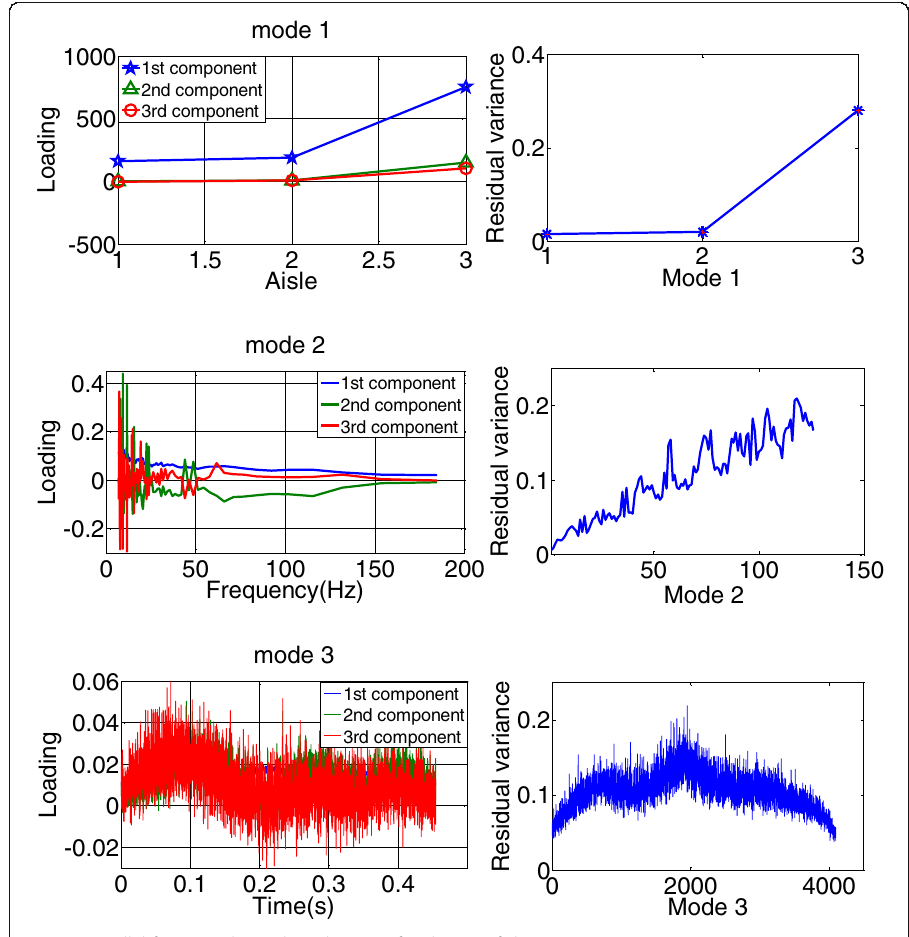
Fig. 17 Parallel factor analysis when the centrifugal pump fails state